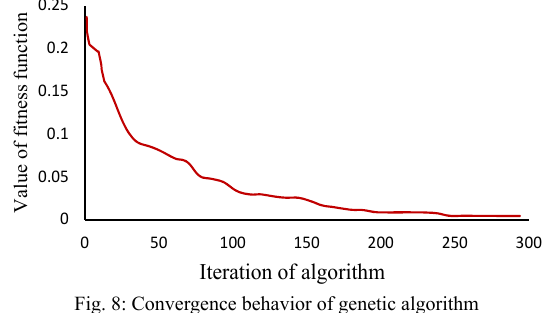
Fig. 8: Convergence behavior of genetic algorithm